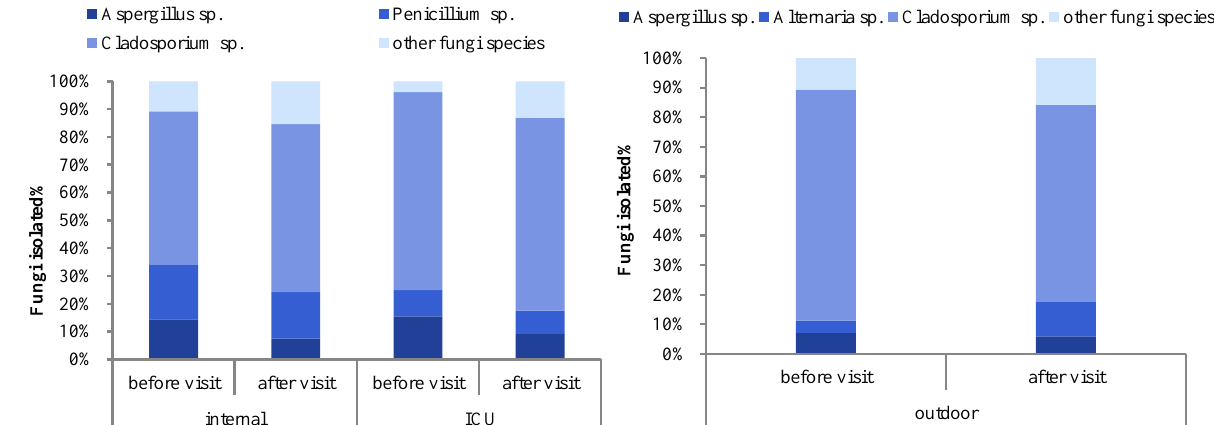
Figure 1. Percentage of fungi isolated in the air samples from indoor and outdoor environments of the hospital during the study